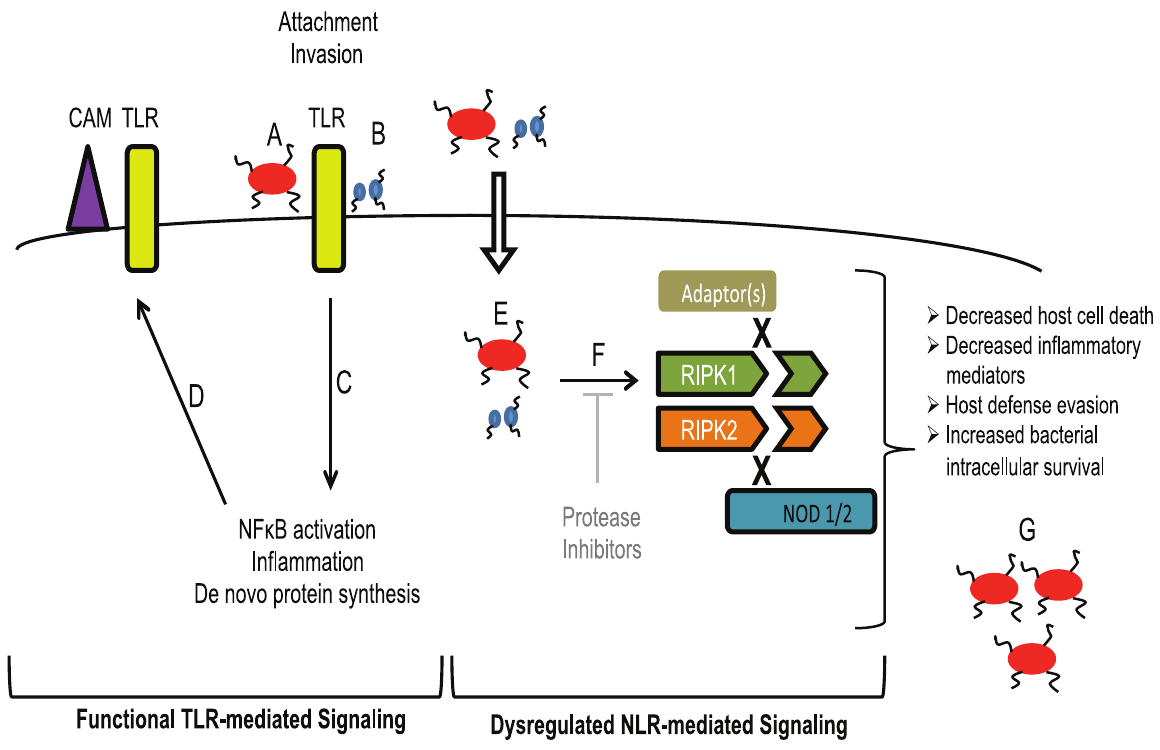
Figure 11. Model of P.gingivalis innate immune activation/invasion in endothelial cells. Outcome of innate immune responses is representative as a balance of functional, intact pathways (TLR-left panel) and dysregulated pathways (NLR-right panel). P. gingivalis represents a human pathogen that utilizes fimbriae for attachment and invasion of endothelial cells. Fimbriae are not only expressed on whole bacteria ( A ), but within outer membrane vesicles (OMV) that are released from the cell ( B ), as occurs with all Gram-negative bacteria identified to date. Fimbriae bind to TLR2 and MD2 to activate TLR2 and TLR4, resulting in the induction of NF- k B, leading to inflammation, and de novo protein synthesis ( C ) of cell adhesion molecules ( CAM ) and TLR ( TLR ) expressed at the cell surface ( D ). Many studies have demonstrated invasion of endothelial cells by P. gingivalis ( E ). However, recent studies have shown that OMV (containing fimbriae and active gingipain activity) gain entry into host cells rapidly in a gingipain-dependent manner ( E ), independent of whole organism. Upon entry, intracellular gingipain activity degrades RIPK1 and RIPK2 (abrogated by protease inhibitors) ( F ), resulting in a variety of possible consequences as a function of selective targeting of intracellular NOD1 or NOD2 (NOD1/2) signaling pathways and/or disruption of RIPK1 or RIPK2-mediated cell signaling. Alteration of immune signaling responses may result in decreased host cell death, decreased inflammatory mediator expression, and subsequent enhancement of intracellular bacterial cell survival, all of which contributes to an intracellular niche for P. gingivalis ( G